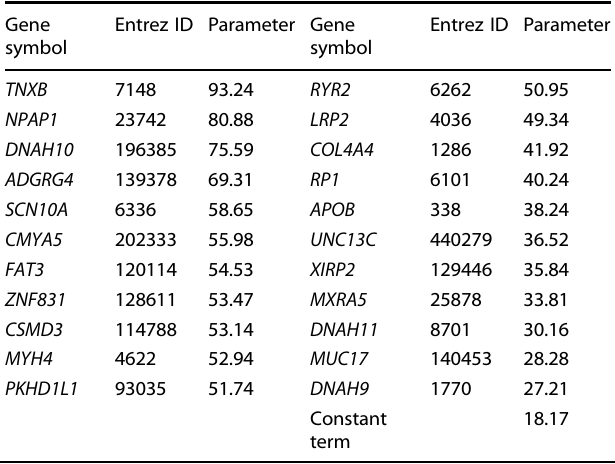
Table 2. Genes and the corresponding parameters used in the constructed melanoma mutation load estimation model